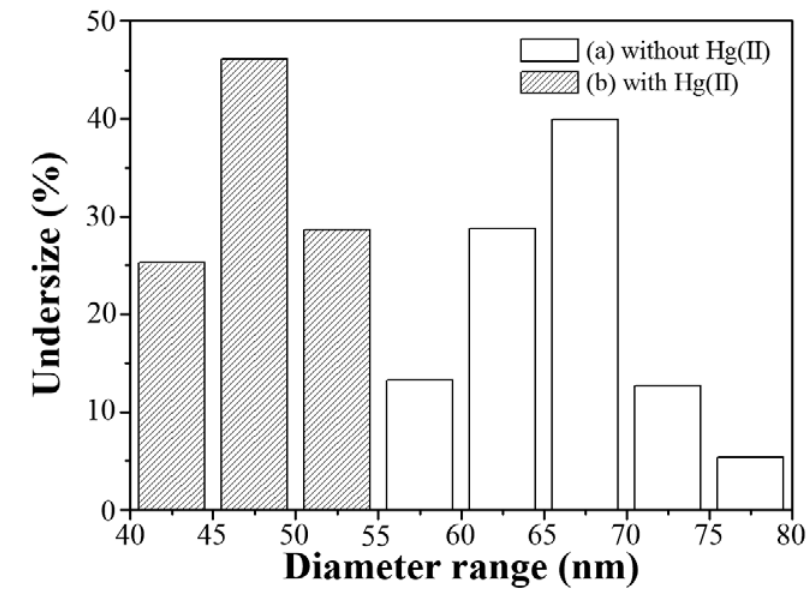
Figure 5. Hydrodynamic diameter distribution of the AuNPs solutions ( a ) without and ( b ) with Hg(II) (1.0 µM) by dynamic light scattering technique.